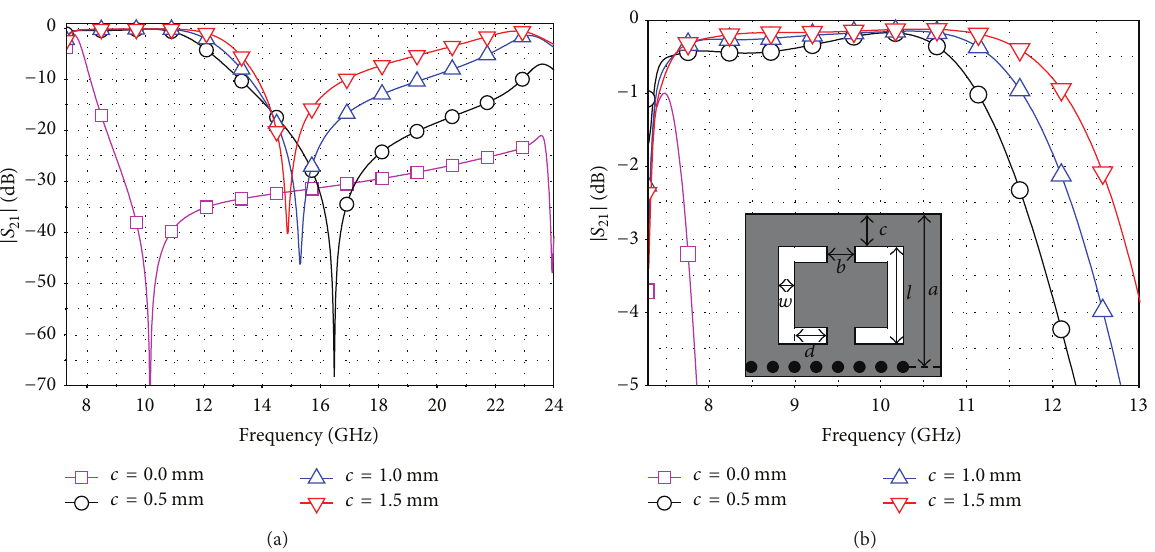
Figure 5: Simulated results of proposed HMSIW-DGS cell with different “ c. ” (a) The whole response and (b) the partial response. Other geometrical parameters are 𝑎 = 7 mm, 𝑐 = 1 mm, 𝑤 = 0.5 mm, 𝑏 = 1 mm, and 𝑑 = 1 mm.